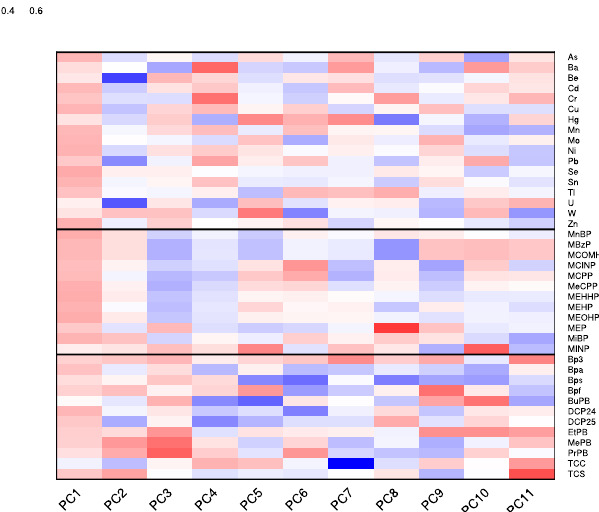
Figure 4. Principal component loading coefficients. This color heat map shows the loading coefficients of the exposures for each of the principal components (PC), demonstrating the relative contribution of each EDC to a specific PC group. Exposures that have a higher positive weight are darker red, whereas exposures that are negatively weighted are blue. Tables 4–6 demonstrate each of the specific PC groupings which were significantly associated with maternal first trimester, maternal term, and delivery cord blood inflammation, respectively. By analyzing the components of a significant PC, one can interpret the association results. For example, in Table 4, PC1 is shown to have positive association with IL-8 and IFN- γ . From Fig. 4, PC1 is positively weighted towards metals and phthalates (red color), suggesting that higher metal and phthalate levels may be positively associated with first trimester IL-8 and IFN- γ .